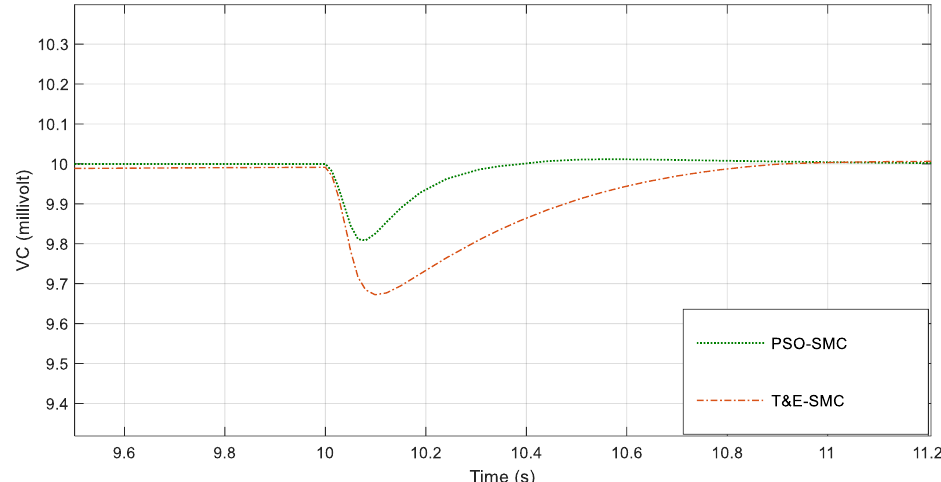
Figure 7. Magnification of Figure 5 around the fifth second.